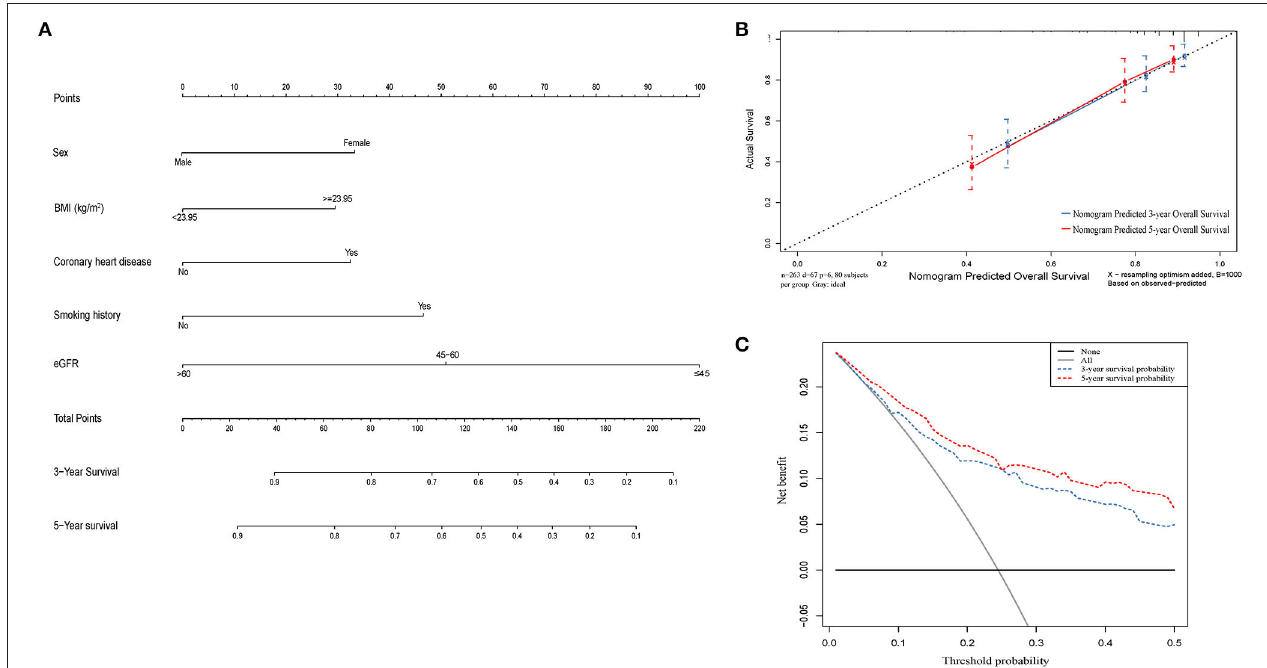
FIGURE 6 | A nomogram model constructed by independent prognostic factors predicting 3- and 5-year OS for UTUC patients (A) ; The calibration curves of the nomogram for 3- and 5- year OS (B) ; Decision curve analysis of the nomogram for 3- and 5-year OS (C) . OS, overall survival; UTUC, upper tract urothelial